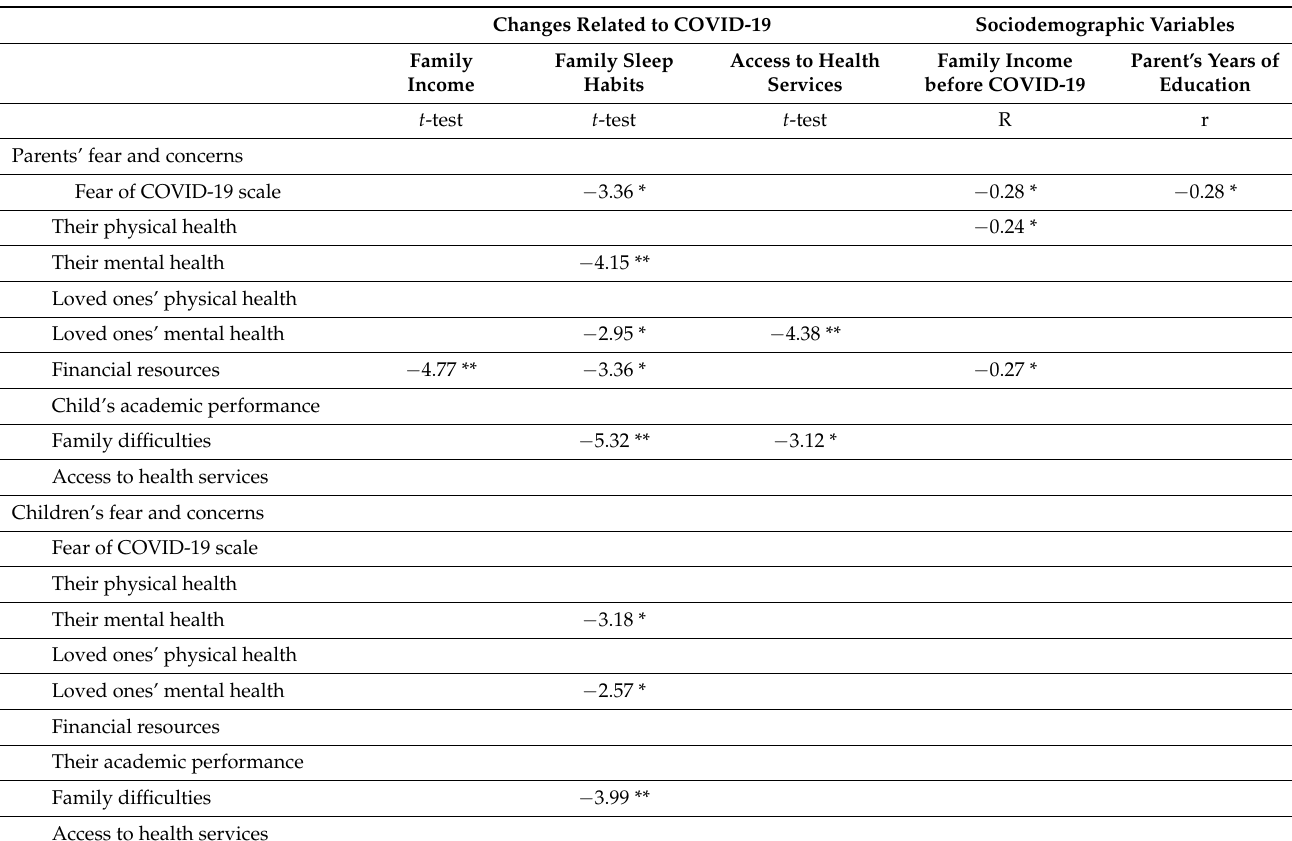
Table 1. COVID-19 fear/concerns in association with COVID-19 related changes and sociodemographic variables: Signifi- cant